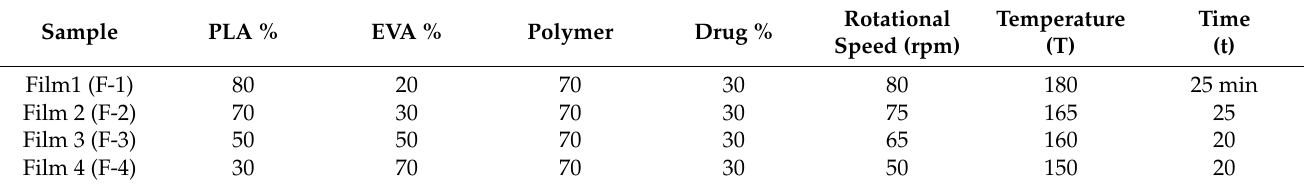
Table 1. Processing parameters and composition of best-chosen